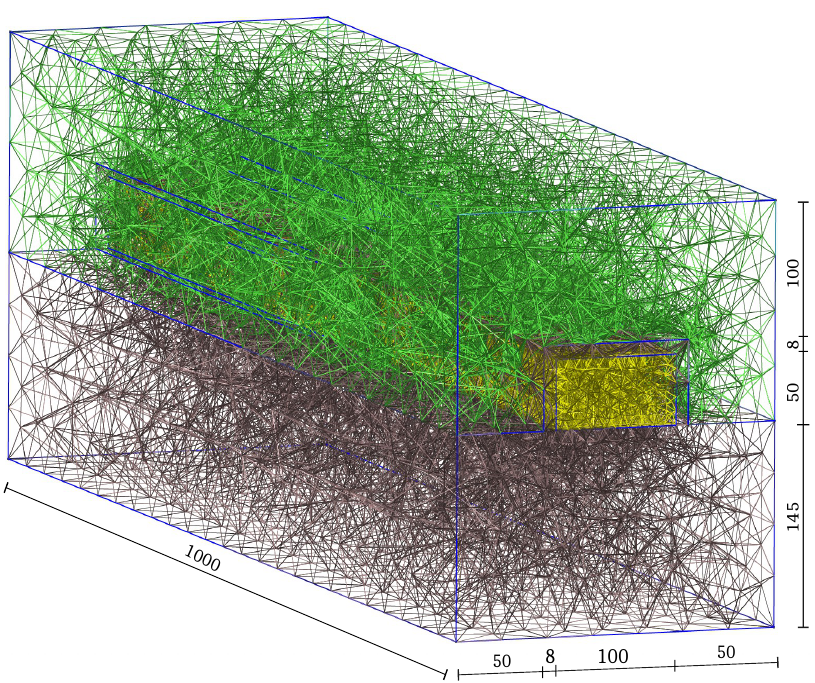
Figure 5. A 3D schematic of the sensor device including the dimensions and tetrahedral meshes for the discretization. All values are in